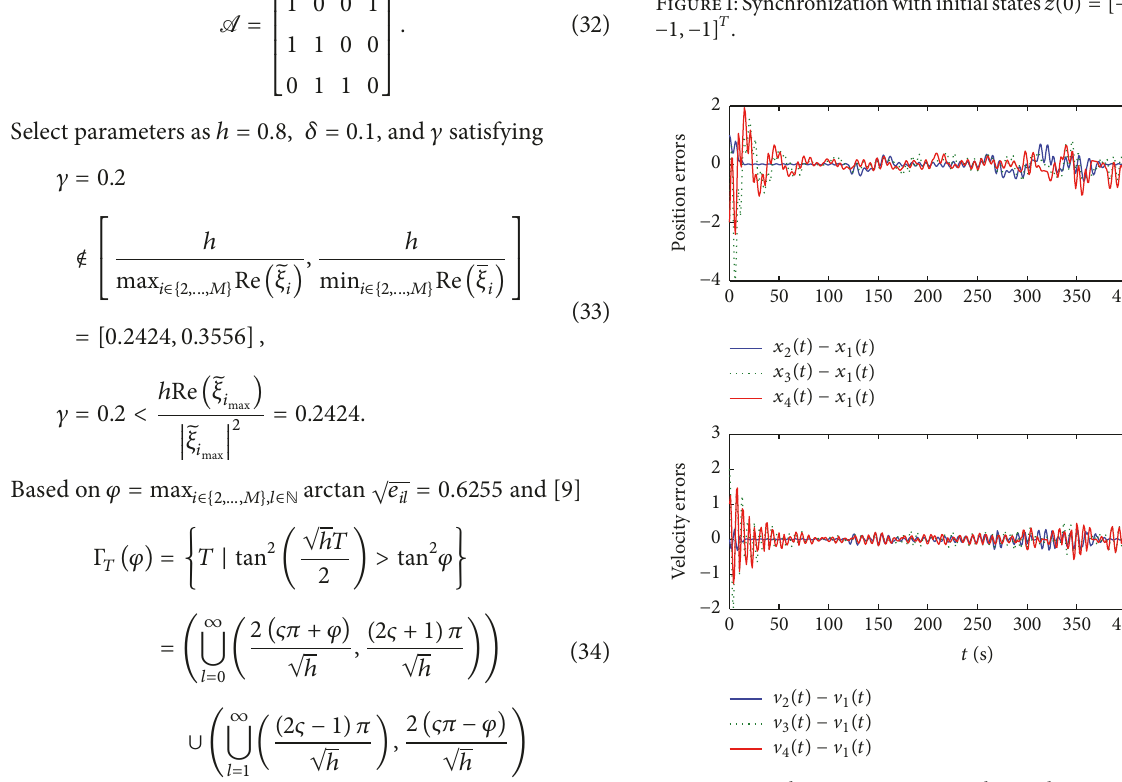
Figure 2: Synchronization errors with initial states 𝑧(0) = [1,0, 2, 0, −1, 2, −1,1] 𝑇